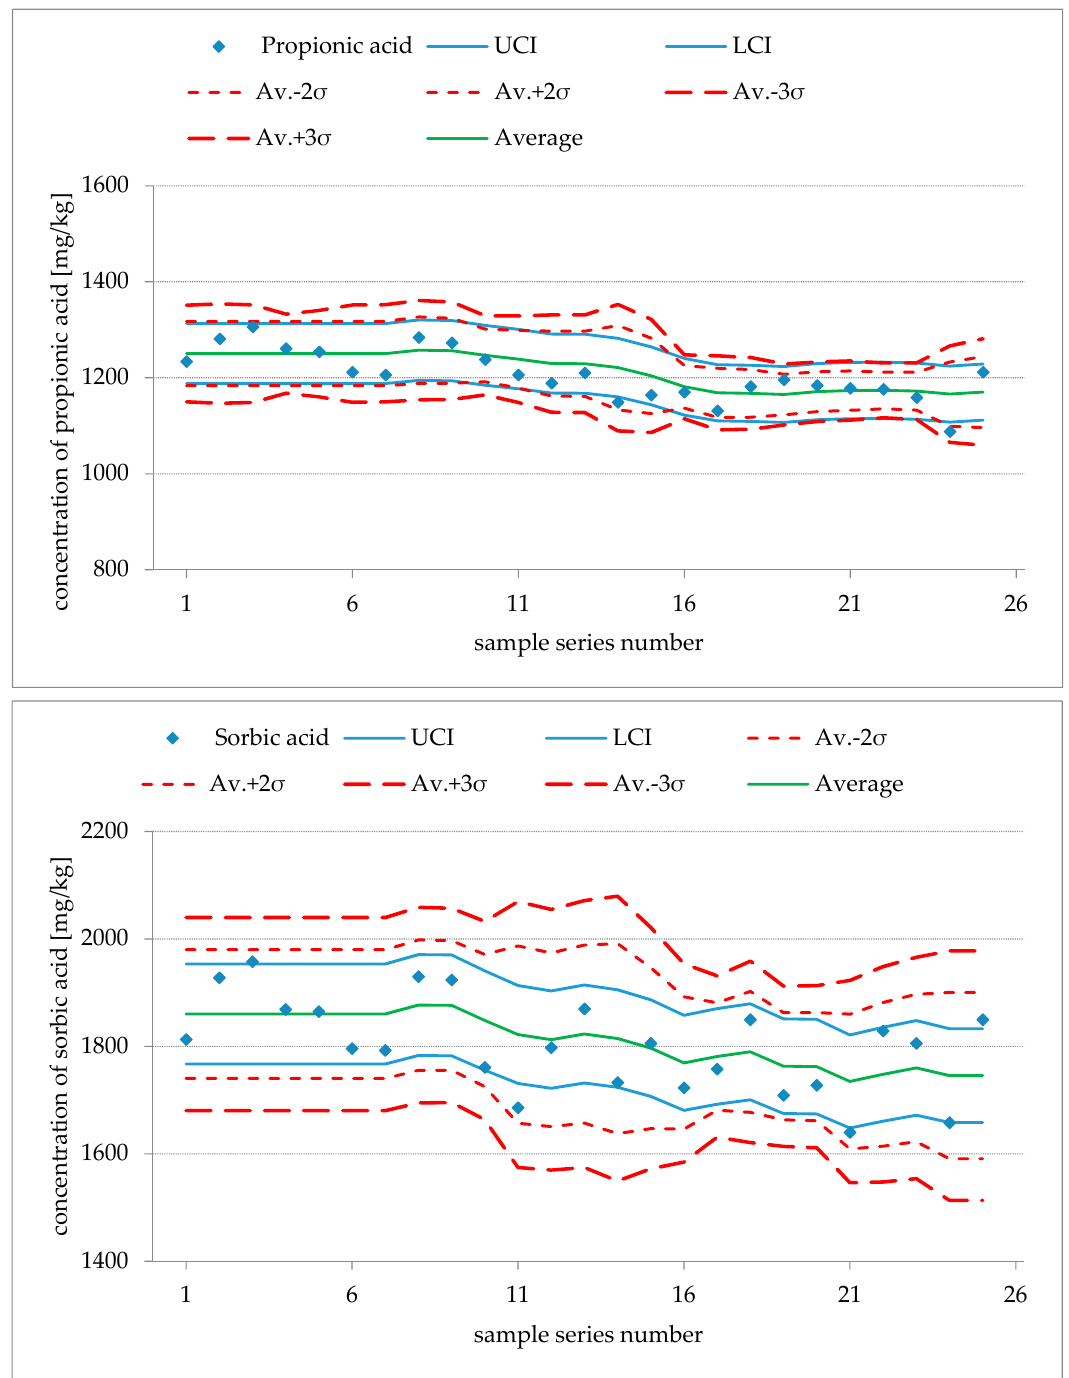
Figure 3. Quality control charts for propionic acid (upper panel) and sorbic acid (lower panel) ( x -axis, sample series number; y -axis, concentration in mg/kg). By analyzing an aliquot of a reproducibility assessment sample with each new sample batch, for both analytes their respective rolling averages and accompanying spans of two and three standard deviations are calculated and monitored. Thus, deviations due to process faults can be detected. The range of 2· σ contains 95% and the range of 3· σ contains 99.7% of the probable results.